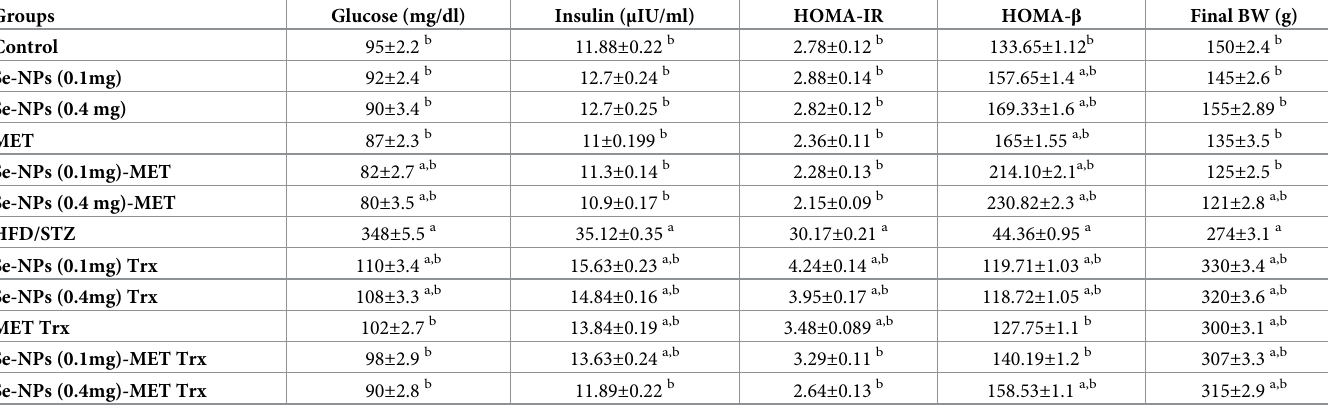
Values are mean ± SE (n = 10). Significant changes (p < 0.01) with respect to control and HFD/STZ-experimental rats are expressed by the letters (a) and (b), respectively.